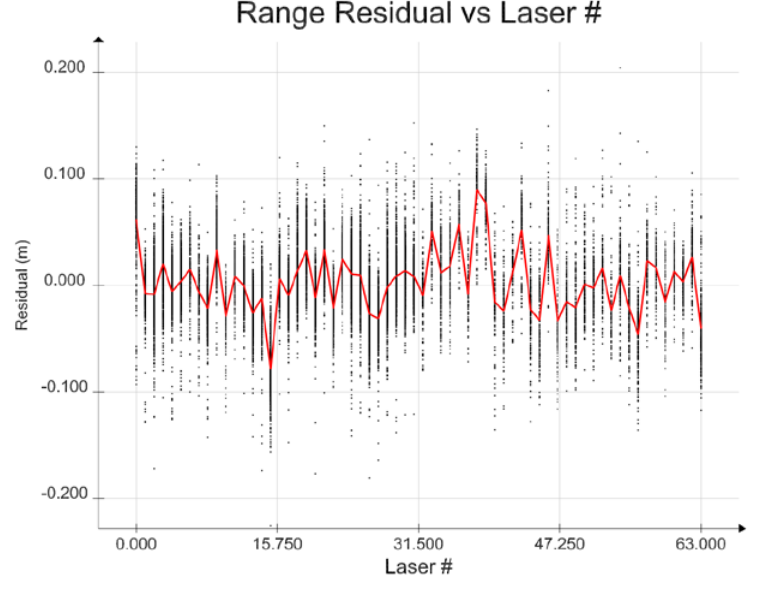
Figure 7. Range Residuals versus Laser # (Red Line = Mean Value).